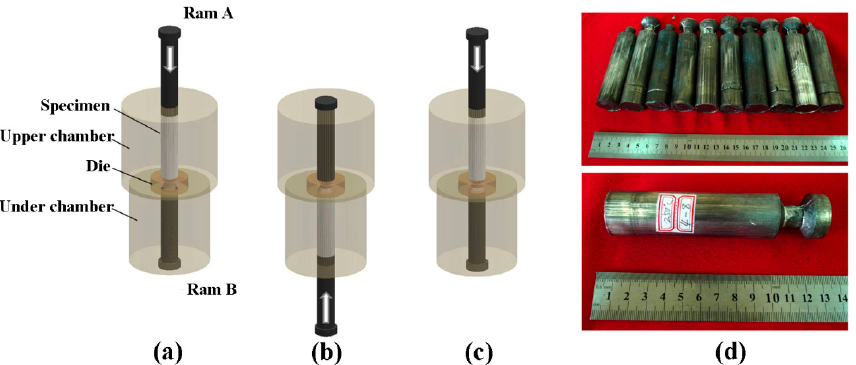
Figure 1. Schematic illustration of the cyclic extrusion and compression (CEC) procedure ( a ) initial state; ( b ) 1P; ( c ) 2P; ( d ) actual picture of the CECed ZK61 alloy rods.